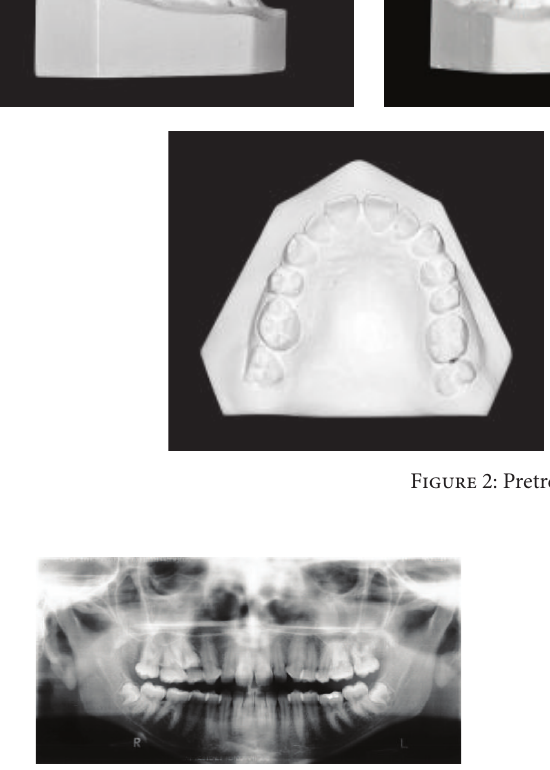
Figure 3: Pretreatment panoramic